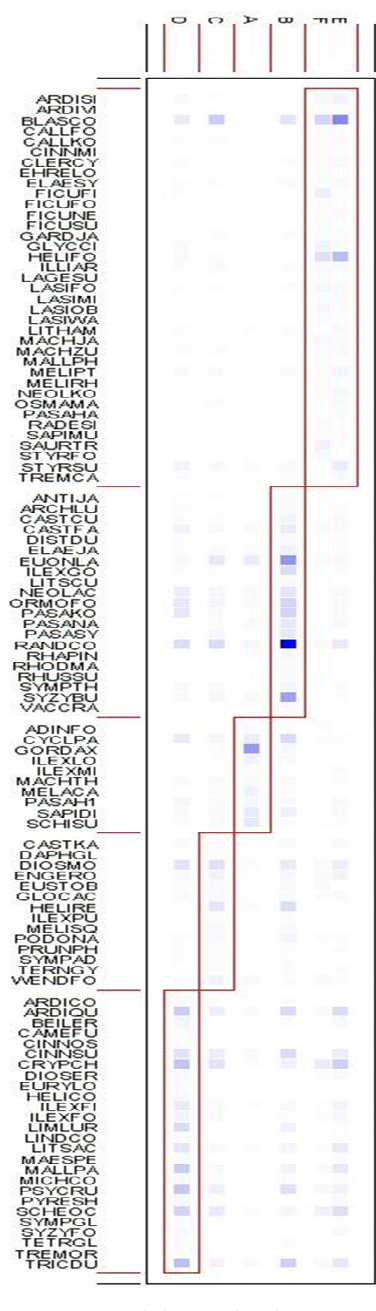
Figure 6. Modularity plot shows 5 modules with the abundance of the corresponding species group by the blue-scale.